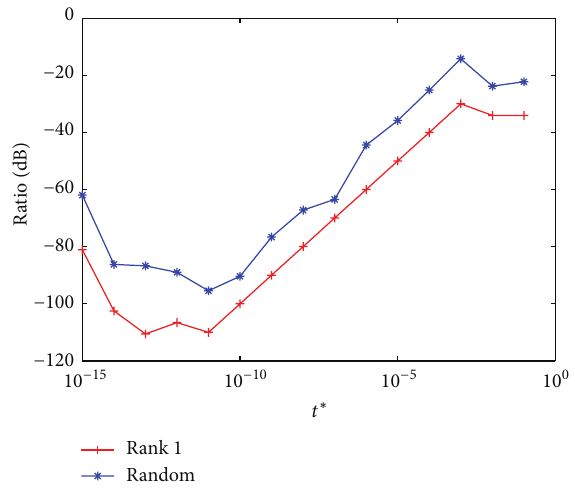
Figure 7: Selection of target and receiver power ratio factors.